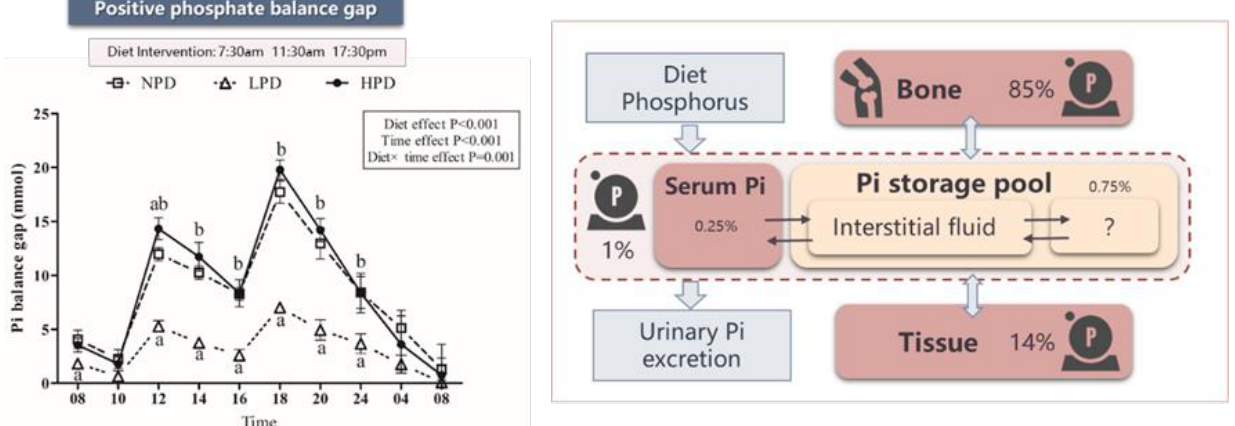
Figure 4. The storage pool severs as a buffer pool for the transient positive phosphorus balance gap. Note: The phosphorus balance gap in the left half of this figure was calculated as follows: phospho- rus balance gap (mg) = phosphorus balance gap at the previous time point (mg) — the urinary phos- phorus excretion at the current time point (mg). Phosphorus balance gap at 08:00 was the first gap. It was calculated as the dietary phosphorus intake of breakfast multiplied by the intestinal absorp- tion rate — the urinary phosphorus excretion at 08:00 (mg). As for phosphorus balance gap at 12:00 and 18:00, the corresponding dietary phosphorus intake per meal multiplied by the intestinal ab- sorption rate were added to the above first formula. Intestinal absorption rate was calculated by 24- h urinary phosphorus excretion divided by dietary phosphorus intake. The arrows in the right half of the figure mean the exchange between different tissues or organs. Abbreviations: LPD, low-phos- phorus diet (500 mg/d), NPD, normal-phosphorus diet (1500 mg/d), HPD, high-phosphorus diet (2200 mg/d).